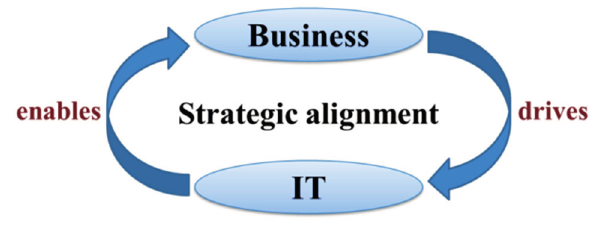
Figure 1. Business and IT strategic alignment.